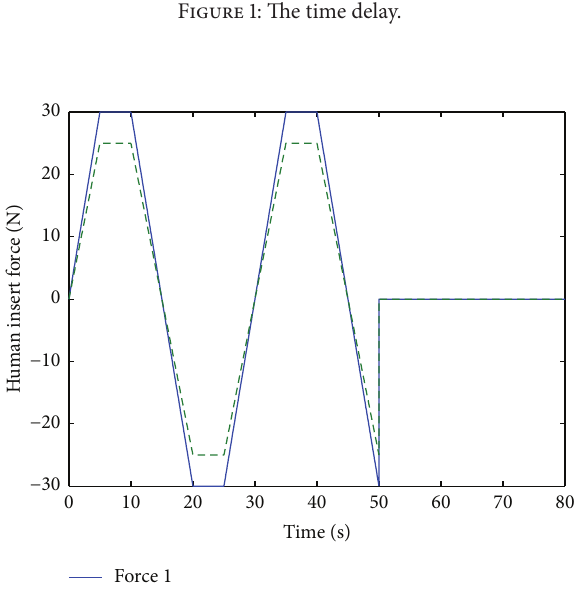
Figure 1: The time delay.